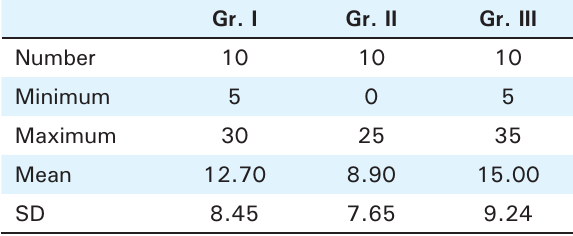
Table 3. Differences of time between shivering started